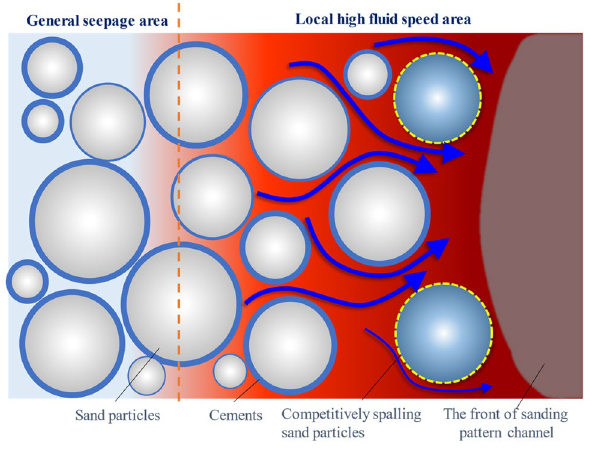
Fig. 14 Schematic diagram of the competitive sand detachment mechanism